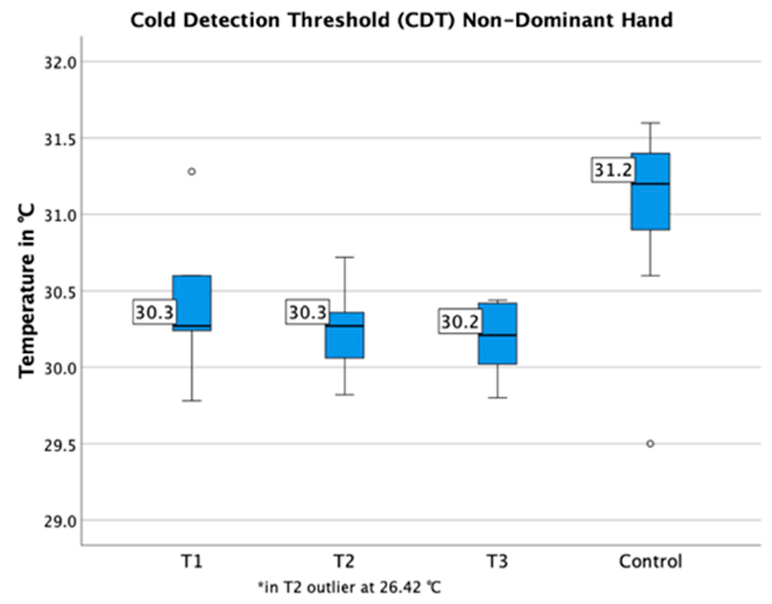
Figure 7. Cold detection thresholds of the control region (hand) are shown. Compared to healthy individuals, detection thresholds for cold temperature were decreased (T1–T3).